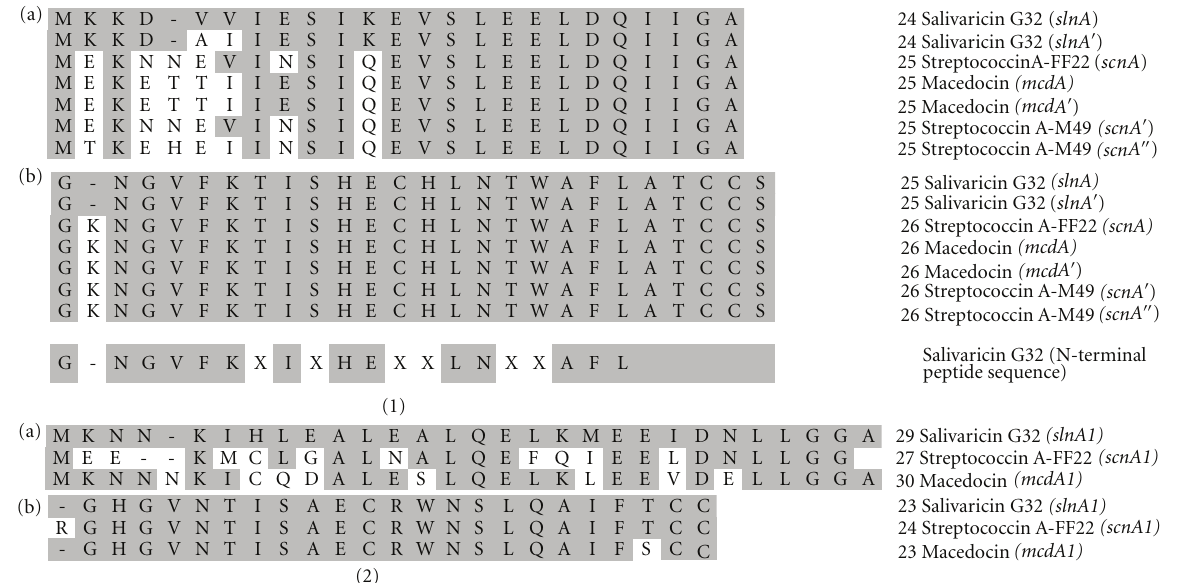
Figure 2: (1) Alignment of (a) the leader sequences and (b) the propeptide sequences of salivaricin G32, SA-FF22, and macedocin (- indicates a spacer introduced to aid the alignment). The N-terminal sequence derived from the purified G32 preparation is shown below, where X indicates a blank cycle in the Edman reaction. (2) Alignment of (a) the predicted translated leader sequences and (b) the predicted translated propeptide sequences for slnA1 , scnA1 , and mcdA1 . The number of amino acids in each sequence is indicated in front of each sequence